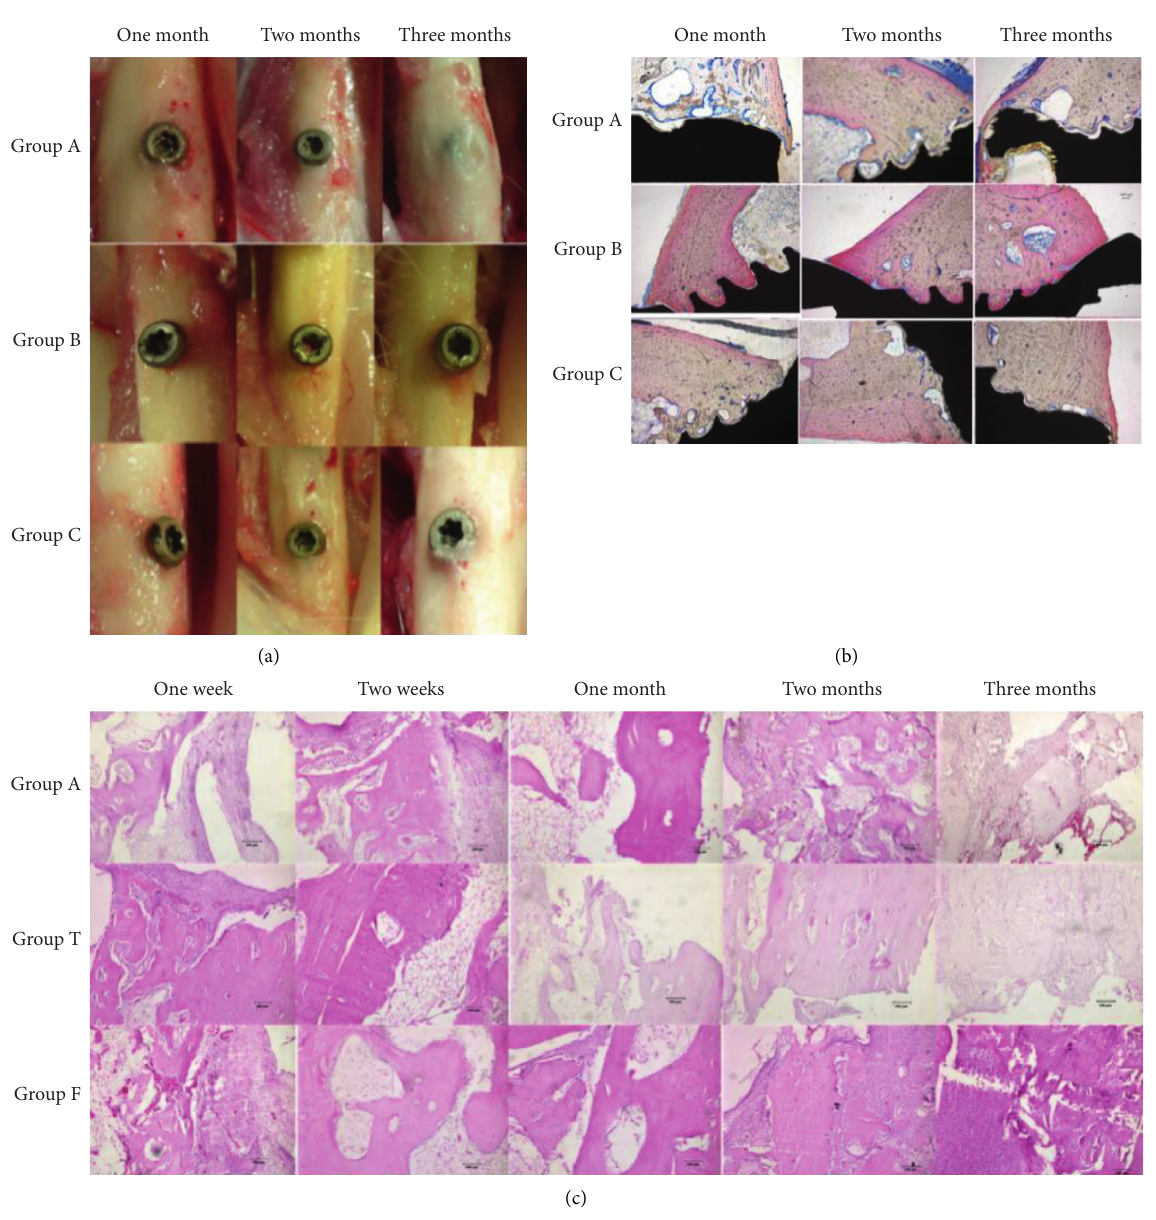
Figure 12: (a) Specimens of bone tissue reaction around implantations in different groups after various intervals of implantation. (b) Hard tissue section of the interface of implantation and bone in different groups after various intervals of implantation. (c) HE-stained sections around the implantations in different groups after various intervals of implantation. Group A, untreated AZ31 magnesium alloy screw; group T, titanium alloy screw; group F, AZ31 magnesium alloy screw coated with fluorine. These results showed that fluorine coating might promote the formation of new bone without obvious inflammatory reaction and fluorine-coated magnesium